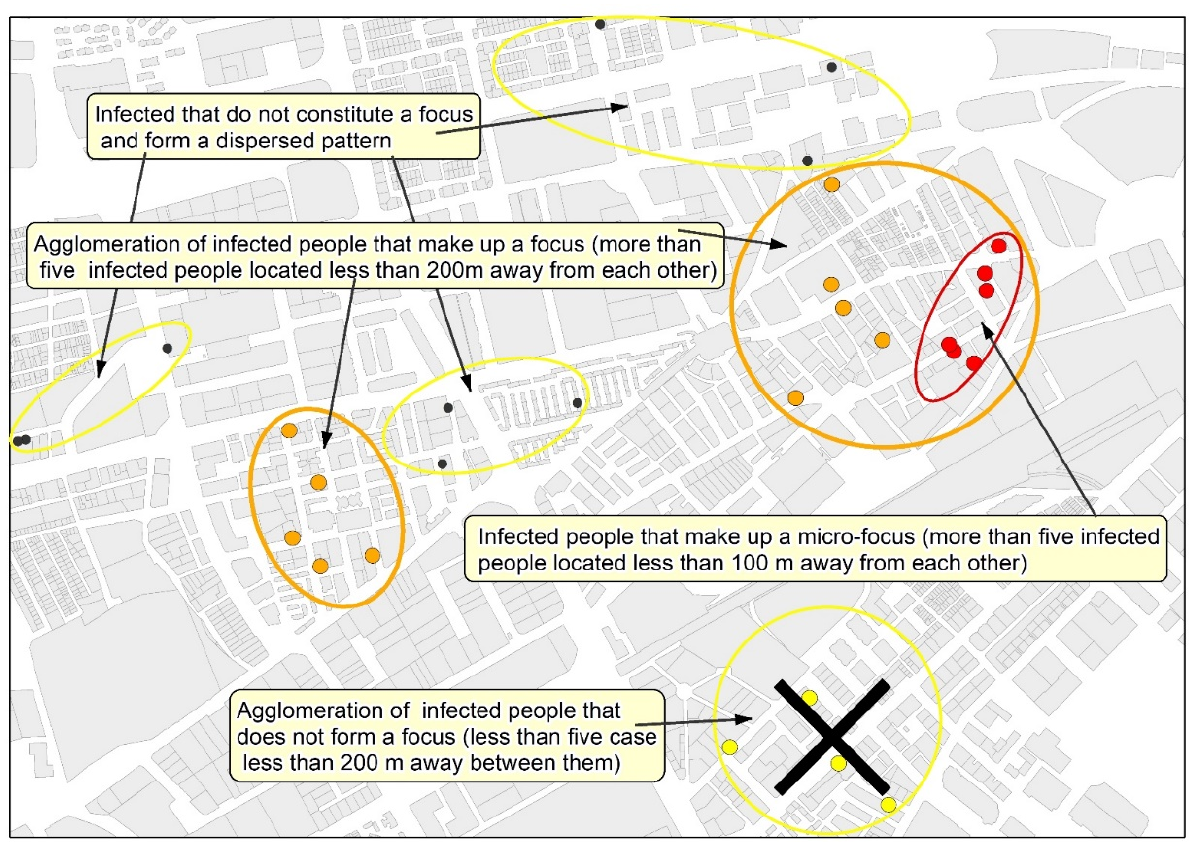
Figure 5. Application of a cluster analysis for the detection of cases according to supervised grouping criteria.